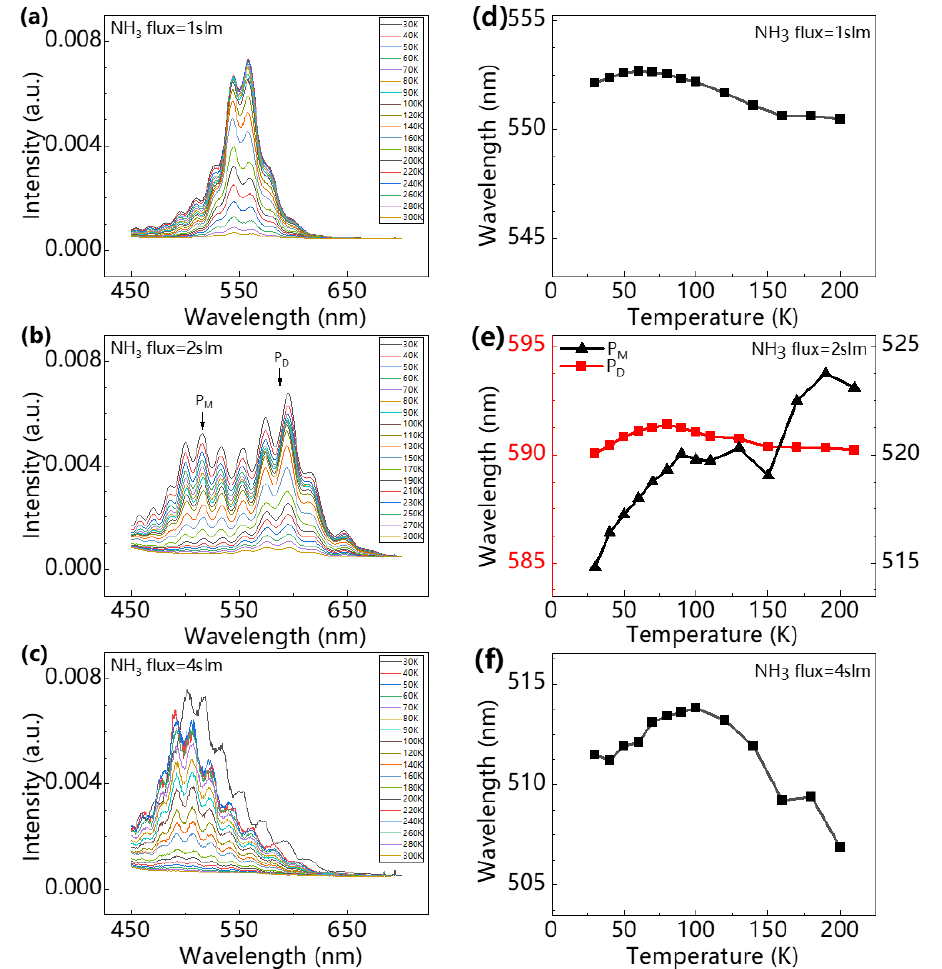
Figure 3. TDPL spectra ( a – c ) and temperature ‐ dependent emission peak wavelength in series II ( d – f ) for samples A, B, and D, grown with NH 3 flux of 1, 2, and 4 slm, respectively. In Figure 3 ( b , e ), PD is assigned to the peak from quantum ‐ dot ‐ like centers, and PM is assigned to the peak from quantum wells. The connected lines in ( d – f ) are shown for visual purposes.